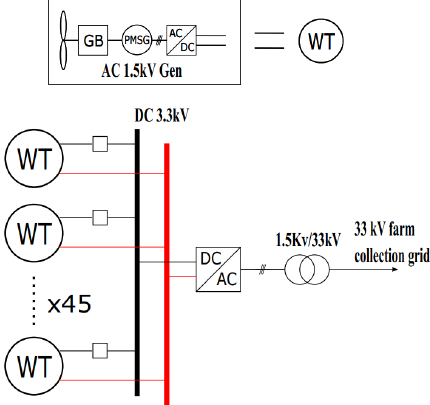
Figure 4. AC cluster topology.